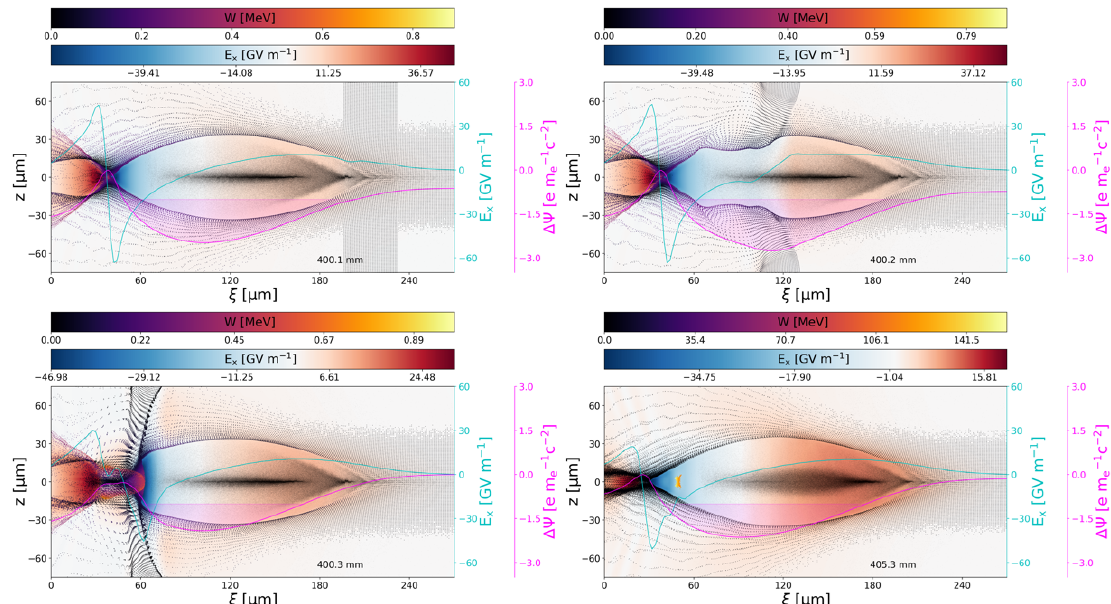
Figure 9. Plasma torch injection in PIC-simulations with VSim. The drive beam (black) propagates to the right and drives a plasma wave based on preionized hydrogen. A laser pulse has generated a helium-based plasma torch perpendicular to the drive beam propagation axis, constitutes a density ramp and triggers density downramp